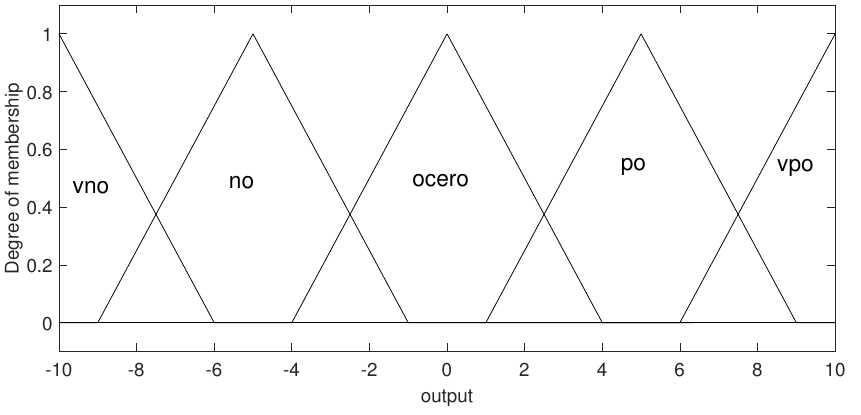
Figure 4. Membership functions for the